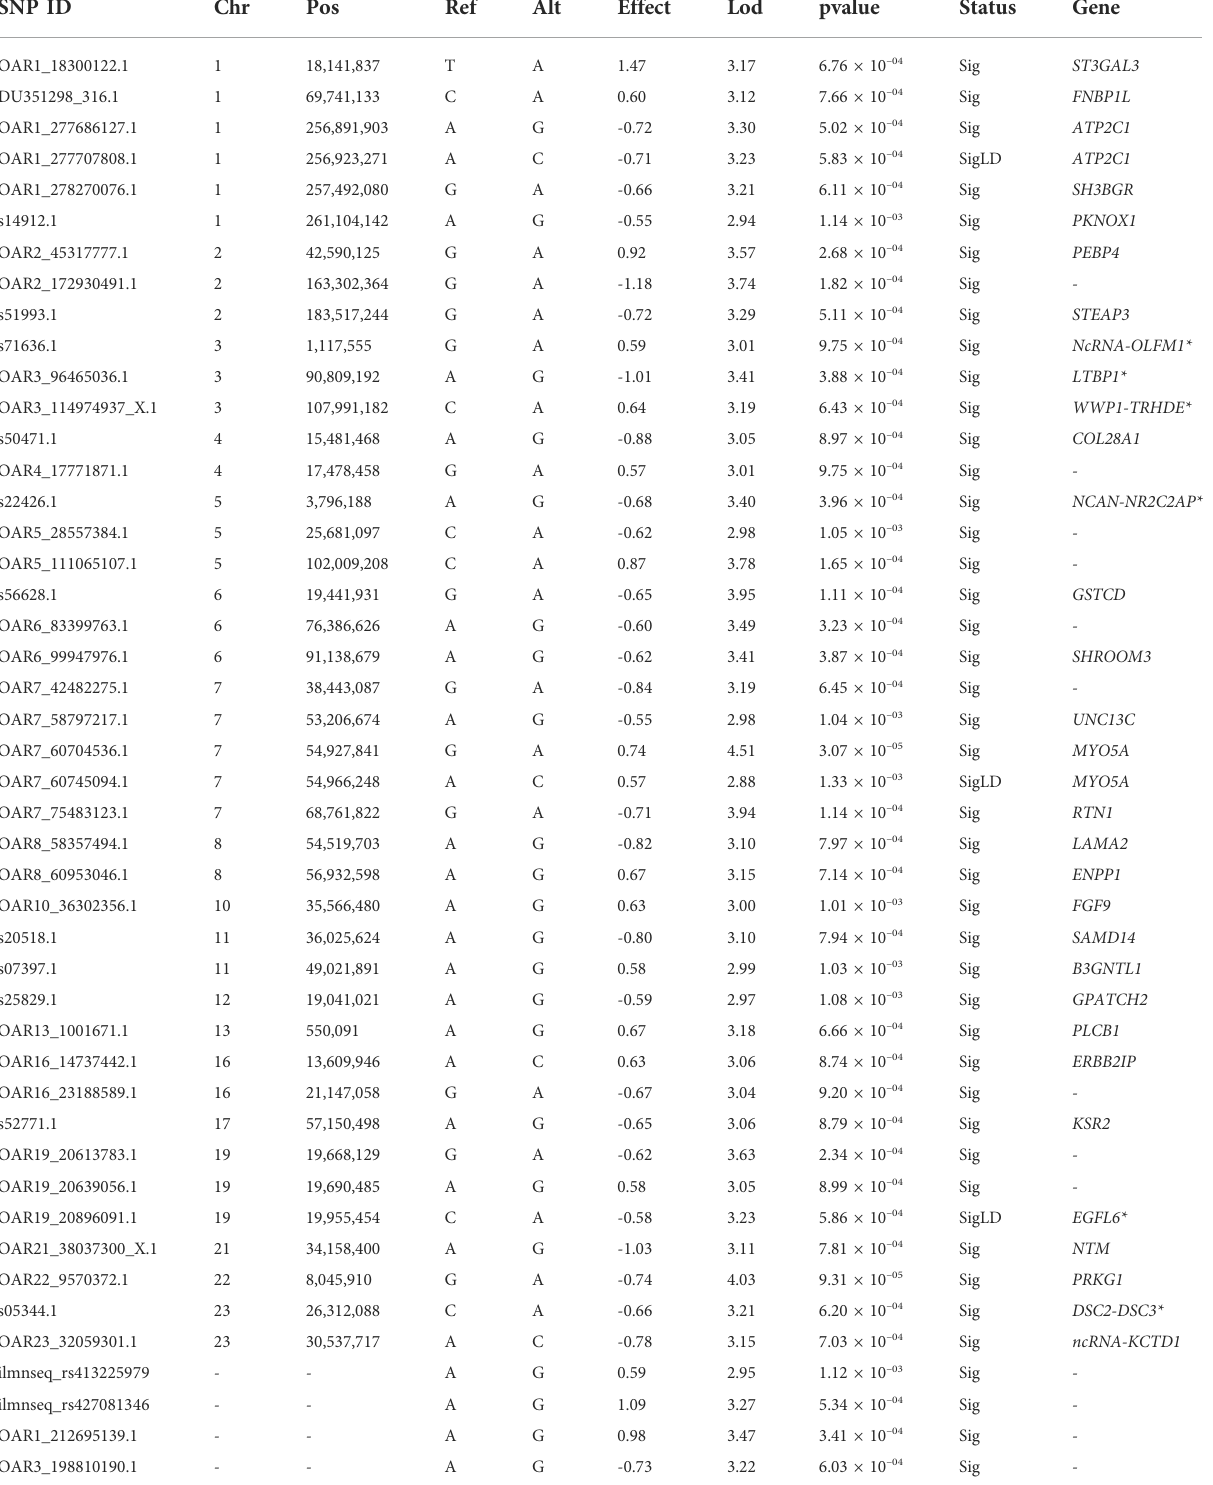
TABLE 3 List of candidate genes associated with the heat tolerance trait in the Egyptian bres studied. The status column indicates the state of SNP signi fi cance and whether it is linked to other SNPs via linkage disequilibrium. SNP